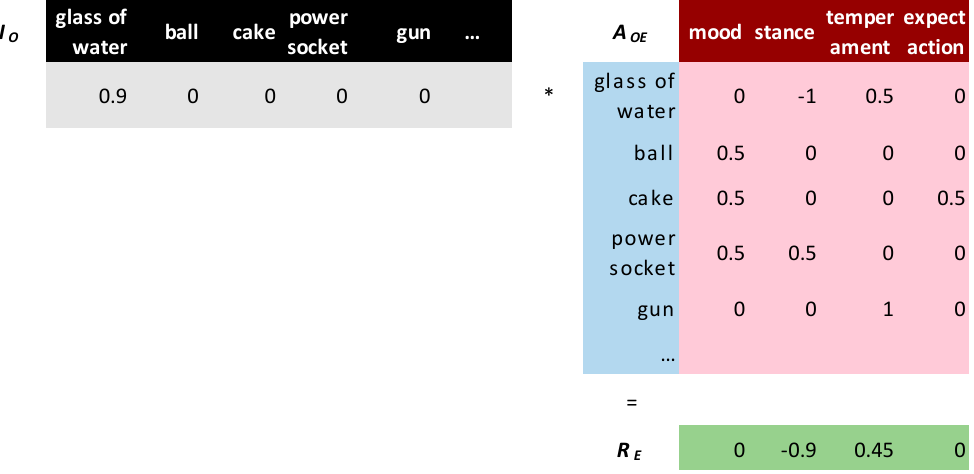
Figure 5. Matrix multiplication resulting in a vector containing parametric emotion.